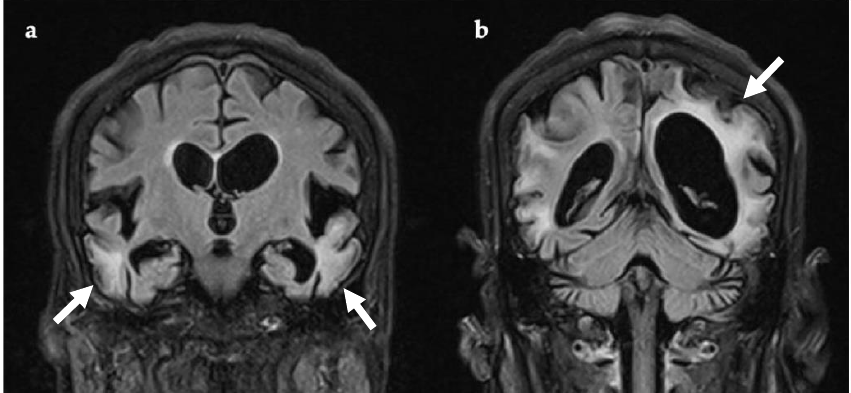
Figure 1. Coronal T2-FLAIR MRI, 21 days after symptom onset. There are multiple areas of supra- tentorial encephalomalacia bilaterally within the temporo-parieto-occipital lobes with parenchy- mal T2 signal change, thinning of gyri, and white matter volume loss (( a , b ), white arrows). Multi- ple vascular territories are involved. Abbreviations: FLAIR, Fluid attenuated inversion recovery